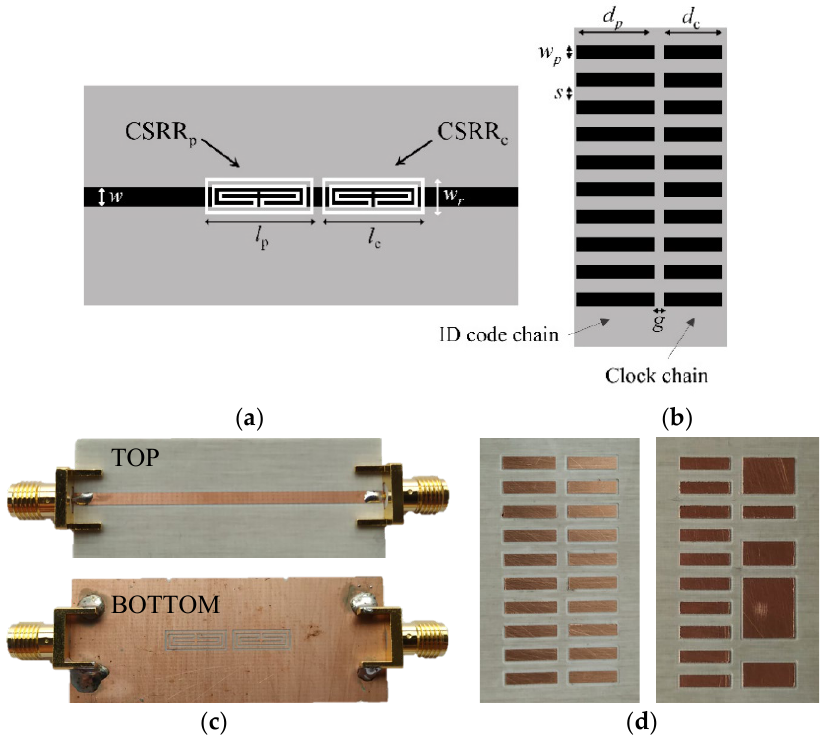
Figure 5. Layout of the reader (stator) ( a ) and specific encoder ( b ), and photograph of the reader ( c ) and two specific encoders ( d ). Dimensions (in mm) are: w = 1.90, w r = 3.30, l p = 9.35, l c = 9.90, d p = 8.15, d c = 8.70, w p = 2.00, s = 2.00, and g = 2.00. The considered substrate for the reader is the Rogers RO4003C with relative permittivity ε r = 3.55, thickness h = 0.81 mm, and loss tangent tanδ = 0.0021. For the encoders, the substrate is the same as the one used in the reader, but with thickness h = 0.204 mm. Reprinted with permission from [64].